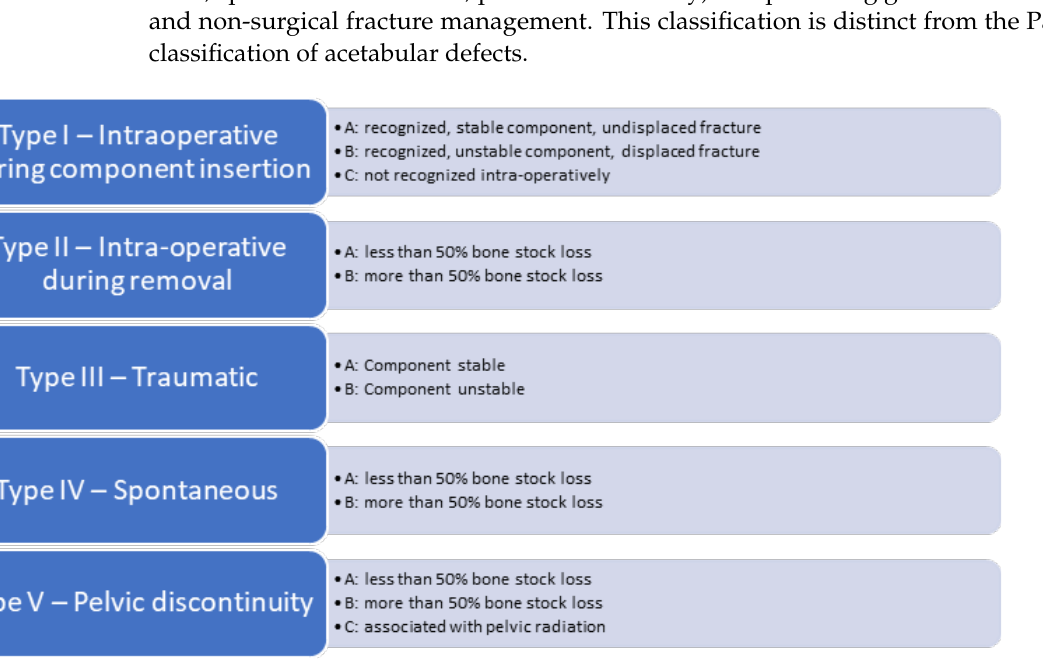
Figure 1. Modified 2003 Paprosky and Della Valle classification for periprosthetic acetabular frac- tures.